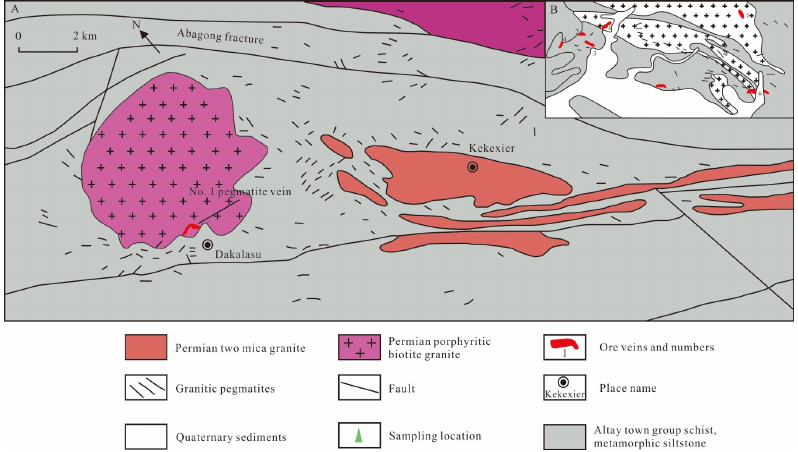
Figure 2. Geological sketch of the Dakalasu pegmatite veins in the Altay region of Xinjiang, modified after [35,56]. ( A ) Geological overview of Dakalasu pegmatite ore cluster; ( B ) Simplified Geological Map of Dakalasu Be-Nb-Ta Ore District.